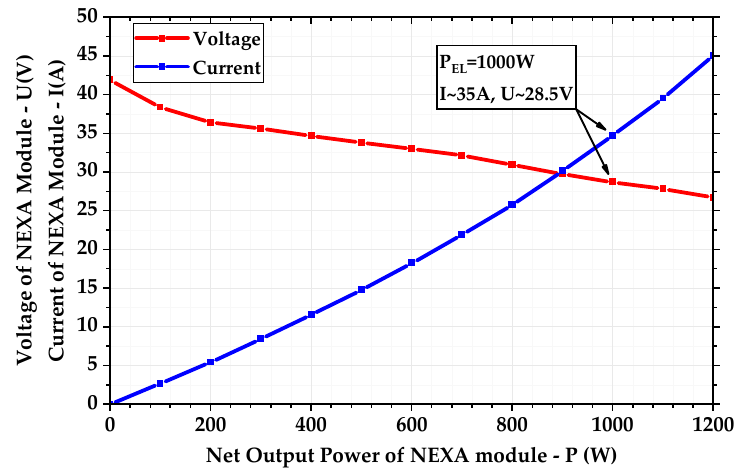
Figure 5. Load characteristics of NEXA FC stack.